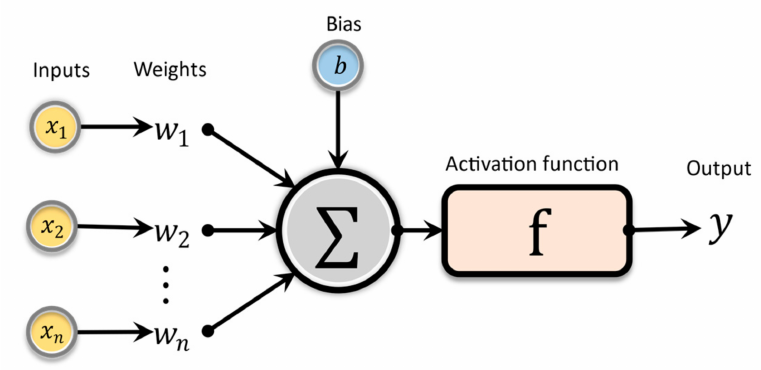
Figure 2. A standard neuron used in an